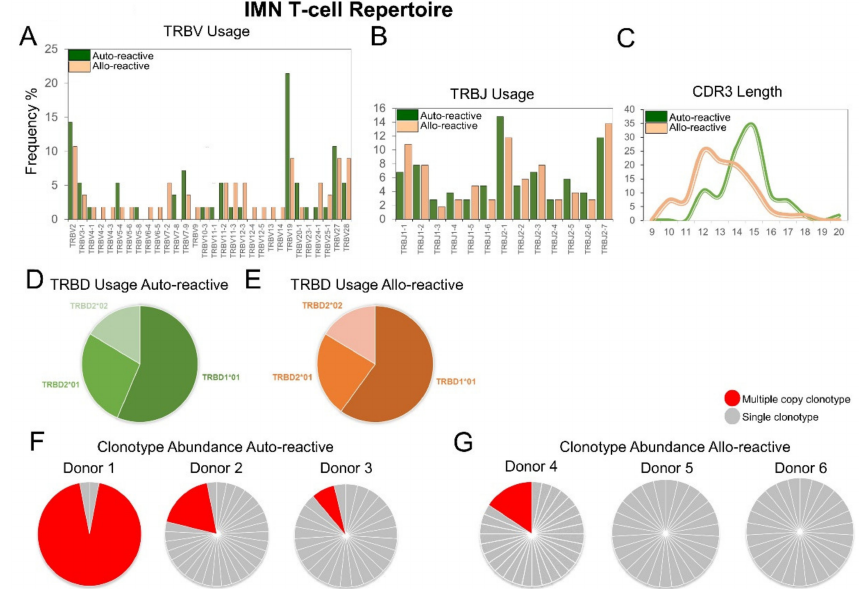
Figure 2. Different IMN-specific T-cell repertoires between auto-reactive donors and allo-reactive donors. Bar charts showing percentage use of ( A ) TRBV and ( B ) TRBJ preference from auto-reactive (green) versus allo-reactive (orange) donors. ( C ) Line chart comparing percentage use of CDR3 length. ( D , E ) Pie charts comparing percentage use of the TRBD genes. Pie charts showing clonotype frequencies in ( F ) three auto-reactive donors and ( G ) three allo-reactive donors. Each slice represents a unique clonotype from the repertoire of a single donor. Unique clonotypes with multiple copies are shown in red and unique clonotypes with a single copy are shown in grey. Percentages were determined by summing the total clonotypes found within a single